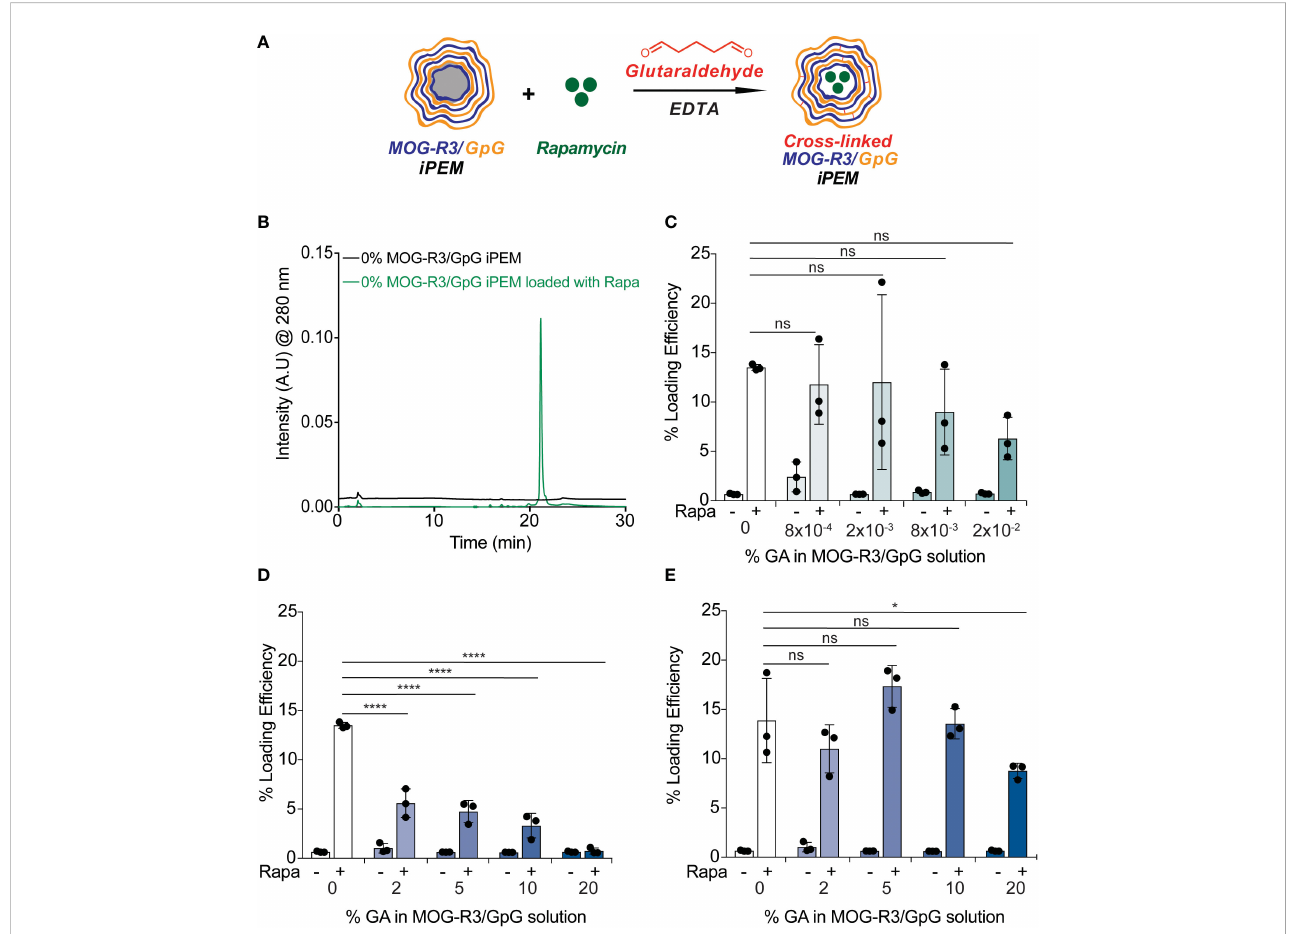
FIGURE 6 Rapamycin loading is achieved in non-cross-linked and cross-linked iPEMs. (A) Schematic view of MOG-R3/GpG capsules loaded with Rapamycin and crosslinked with glutaraldehyde. (B) High performance liquid chromatography trace indicating Rapa loading in non-cross-linked iPEMs. (C, D) Loading ef fi ciency = mg drug loaded/mg drug initial of iPEMs loaded for 5 minutes with Rapa. (E) Loading ef fi ciency of iPEMs loaded for 2 hrs with Rapa. Data represents (n = 3 ± standard deviation). Two-way ANOVA followed by Tukey ’ s multiple comparisons test used to assess statistical differences between samples. *p < 0.05, ****p < 0.0001, ns, not signi fi